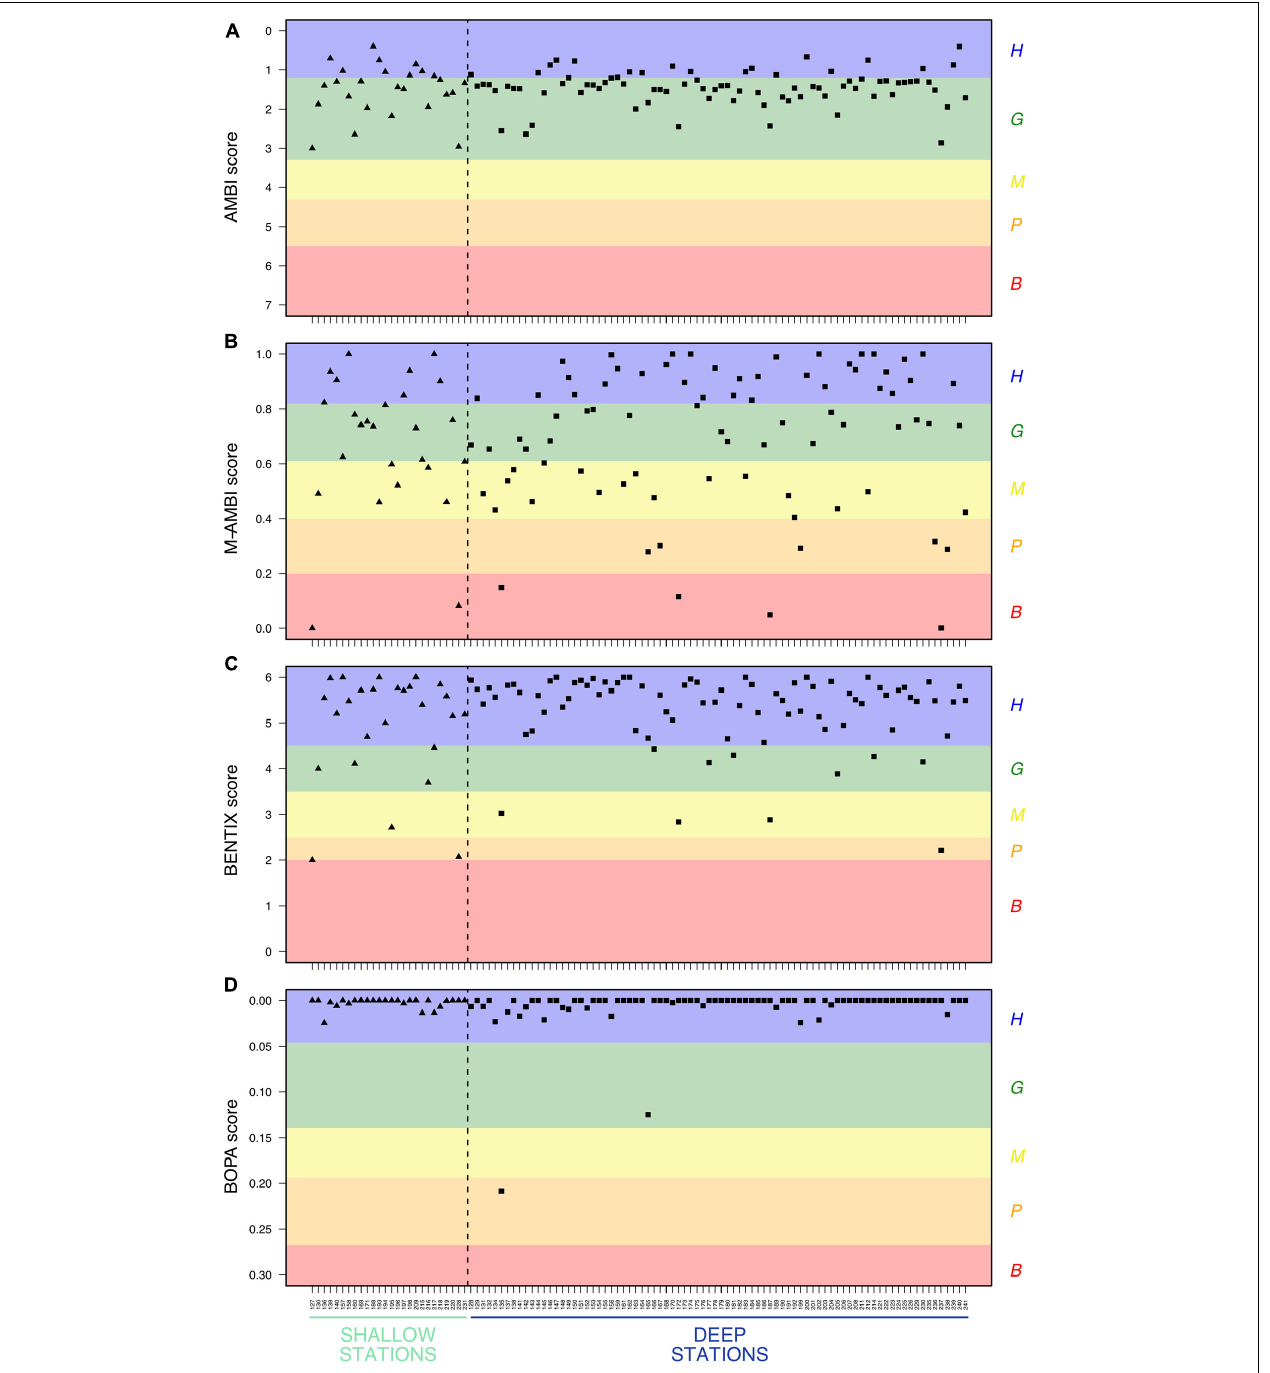
FIGURE 3 | Values of Category 3 indicators ranked according to Ecological Quality Ratios, calculated for shallow and deep stations. (A) Calculated with the AZTI Marine Biotic Index (AMBI), (B) Calculated with the Multivariate AZTI Marine Biotic Index (M-AMBI), (C) Calculated with the BENTIX, (D) Calculated with the Benthic Opportunistic Polychaetes Amphipods Index (BOPA). B = “bad” status (red), P = “poor” status (orange), M = “moderate” status (yellow), G = “good” status (green), H = “high” status (blue).